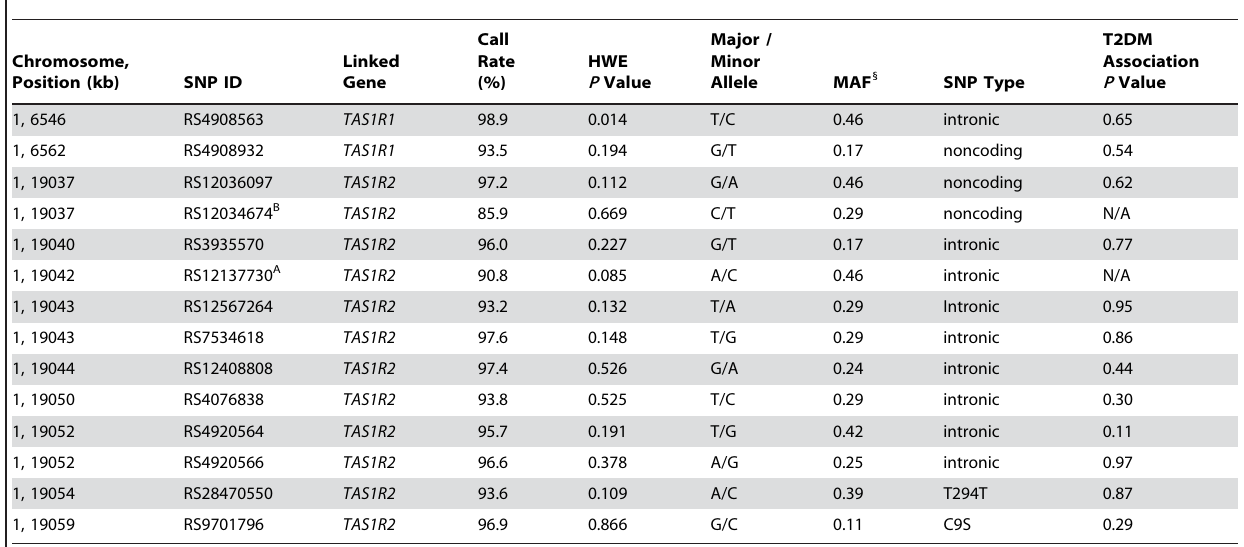
Table 3. Genotyping Statistics for TAS1R SNPs tested in the AFDS.